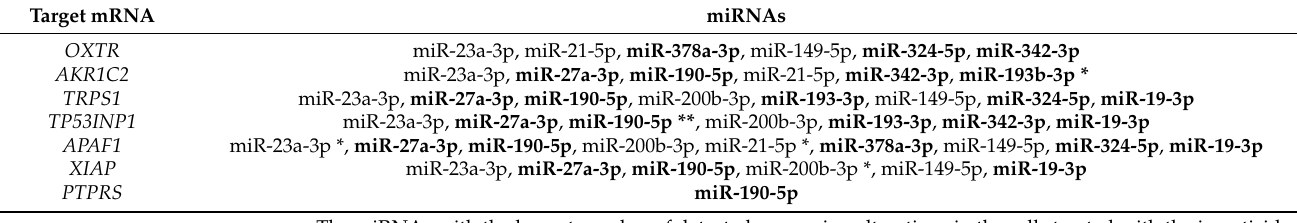
Table 8. The studied miRNAs and their target mRNAs in